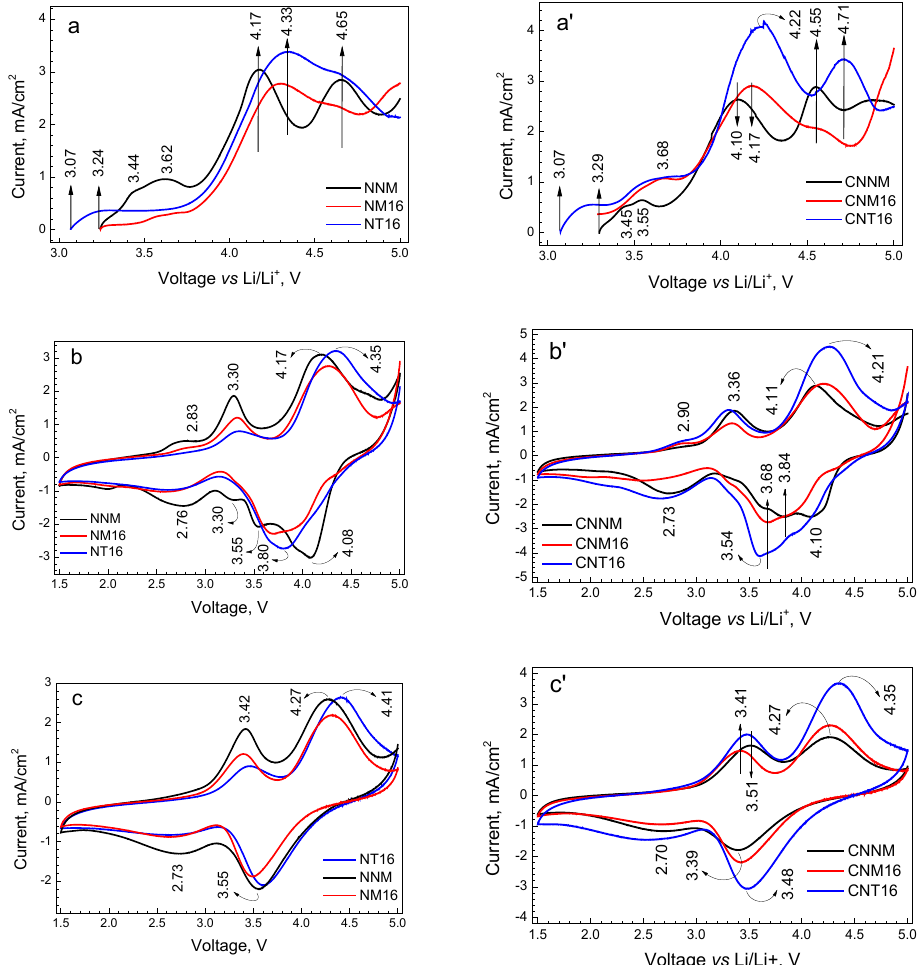
Figure 7. CV curves of metal-substituted oxides ( a – c ) and their CeO 2 -treated analogues ( a’ – c’ ) in lithium-ion cells: (i) first anodic scan ( a , a’ ); (ii) the corresponding cathodic scan and next anodic scan ( b , b’ ); (iii) CV curves after five cycle ( c , c’ ). The scan rate is 1 mV/s. The reverse cathodic scan produces the appearance of several peaks between 4.1 and 2.0